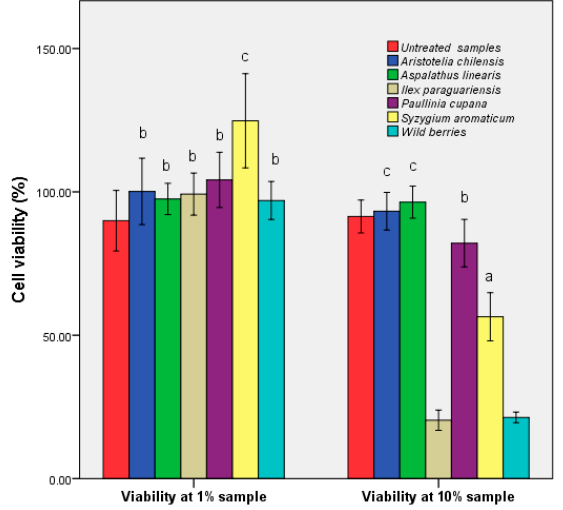
Figure 7. Evaluation of the HCT-8 cell viability via MTT assay in the presence of hydroalcoholic extracts. Different letters represent significant statistical differences (untreated sample vs. samples; p ≤ 0.05), n = 3; untreated sample was used as control.